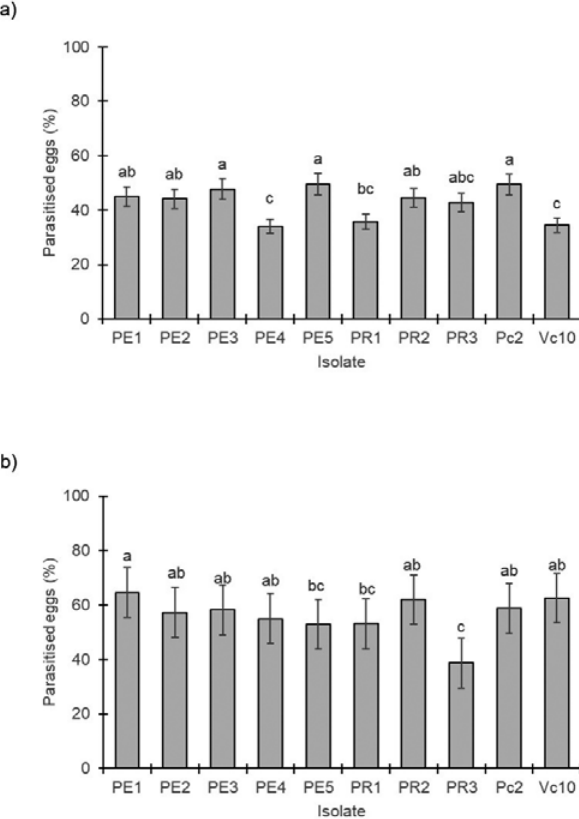
Figure 3. Mean percentages of parasitised eggs of Globodera pallida (a) and Meloidogyne incognita (b) by ten Pochonia chlamydosporia isolates (PE1, PE2, PE3, PE4, PE5, PR1, PR2, PR3, Pc2 and Vc10) after incubation at 25°C for 3 d (refer to Table 1 for isolate informa- tion). Bars represent standard errors of means. Columns accompa- nied by the same letter are not significantly different (LSD test; P <